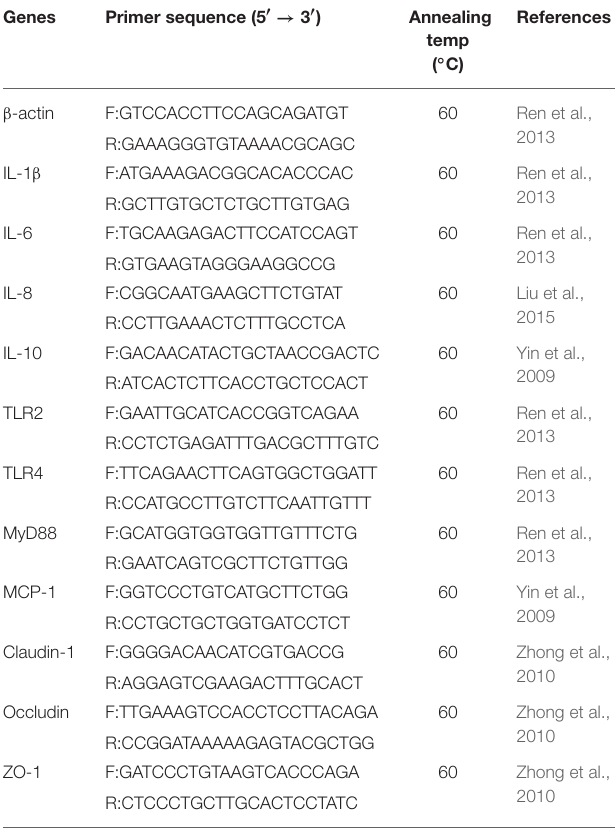
TABLE 1 | Primers used for the relative quantification.